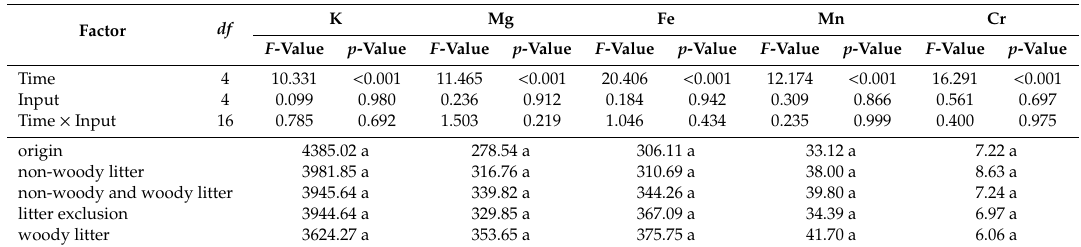
Table 8. E ff ects of time, debris input and their interaction on metals storage of sediment tested by repeated-measure ANOVA